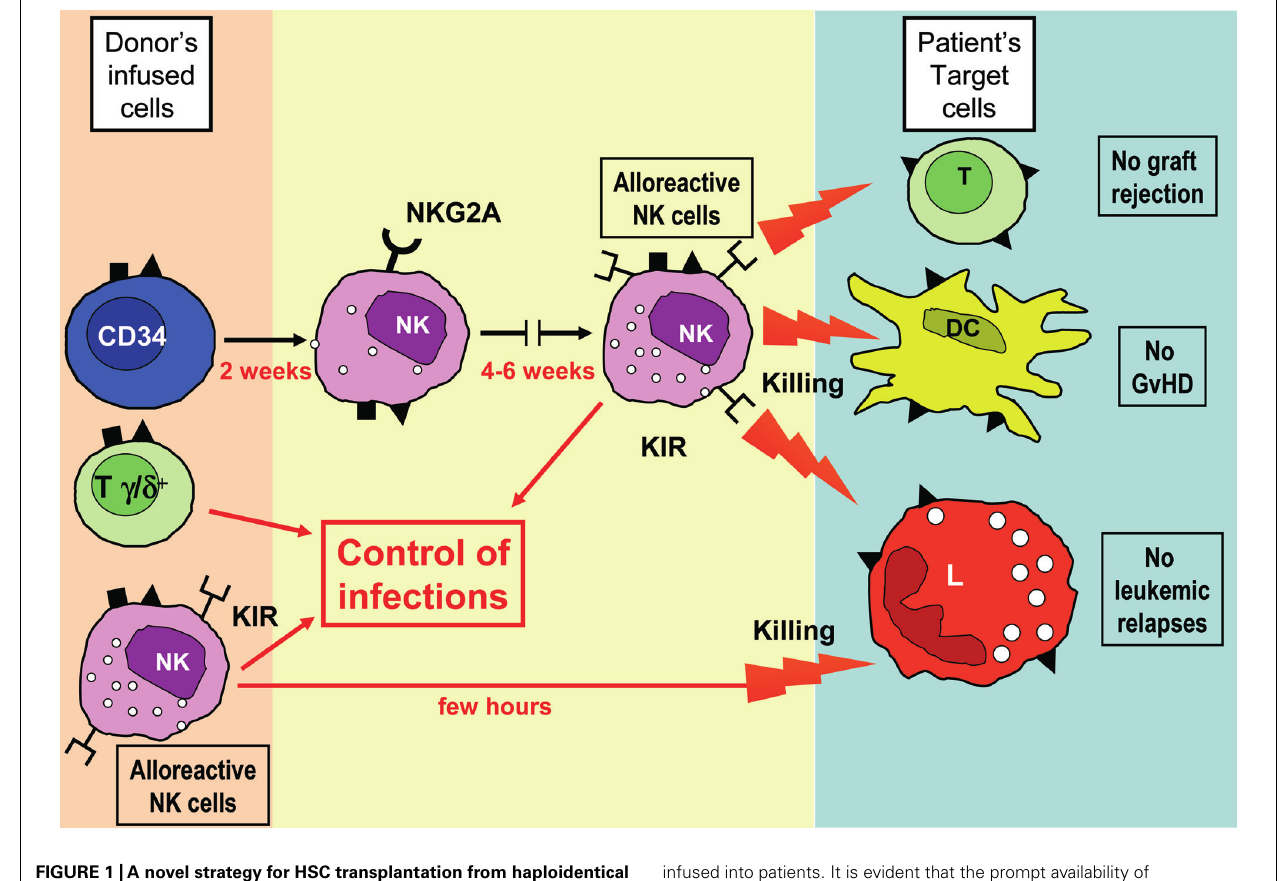
infused into patients. It is evident that the prompt availability of alloreactive effector cells may greatly improve the anti-leukemia effect and the removal of residual patient’s DCs andT lymphocytes, thus ensuring a more efficient prevention of leukemic relapses, GvHD and graft-rejection. In addition, transplanted NK and γ / δ T cells may provide a first line of defense against different infectious